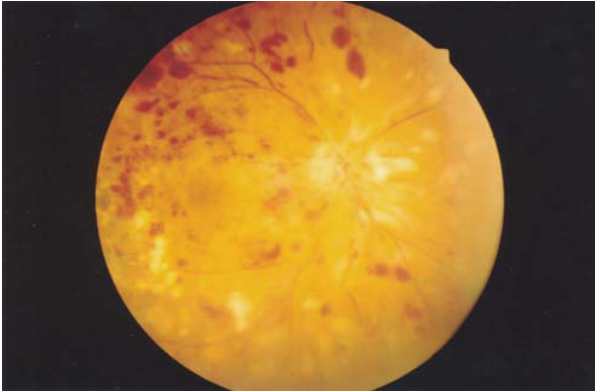
Figure 2 - Color retinography of the right eye after the cryoablation and the intravitreal injection. Two days before this picture, before the treatment, the cornea was edematous and the fundus barely visible. Vascular changes such as venous sheathing, intravascular stop of the blood column, arteriolar thinning, retinal hemorrhages, and cotton wool spots were also visible throughout the entire